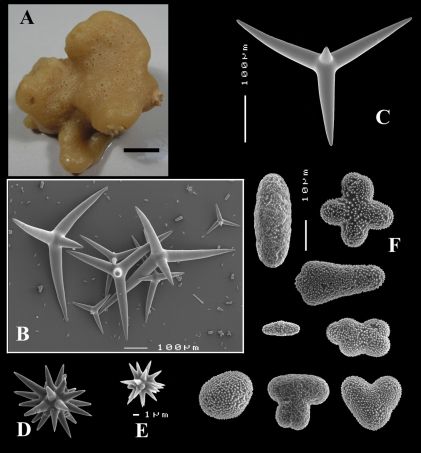
Calthropella (Pachataxa) enigmatica, paratype MNHN DCL 2895 from New Caledonia, A habit (photo P. Cárdenas, scale bar 1 cm) B overview of spicules C calthrops D larger oxyaster E smaller oxyaster F various ataxasters.